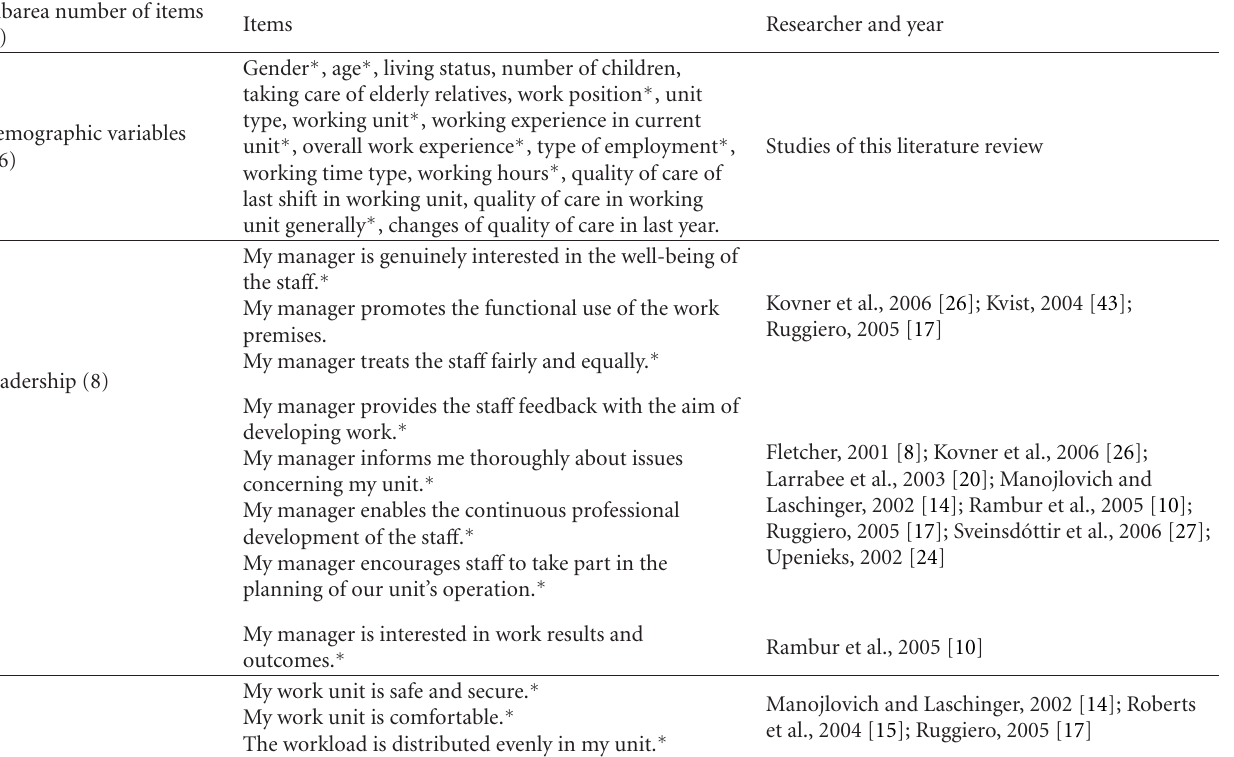
Table 1: Job satisfaction subareas and items identified on the basis of the literature review ( ∗ the item is in KUHJSS in 2008). Subarea number of items ( n )